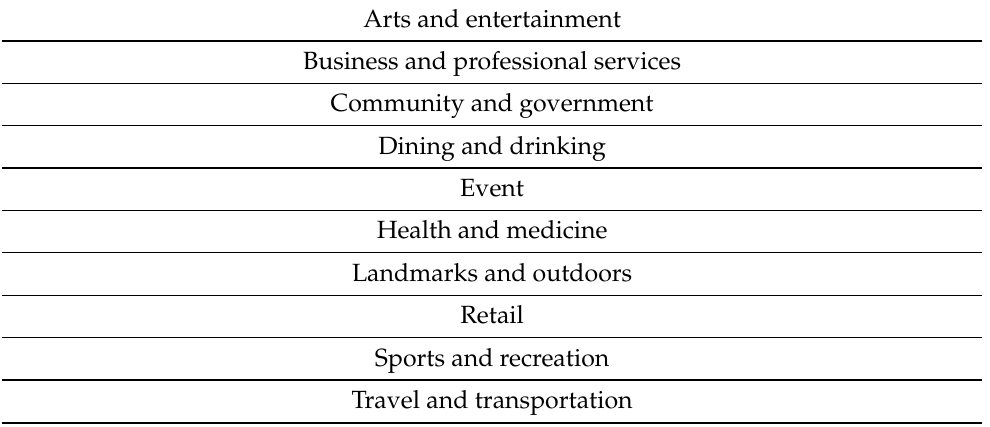
Table A1. Foursquare category